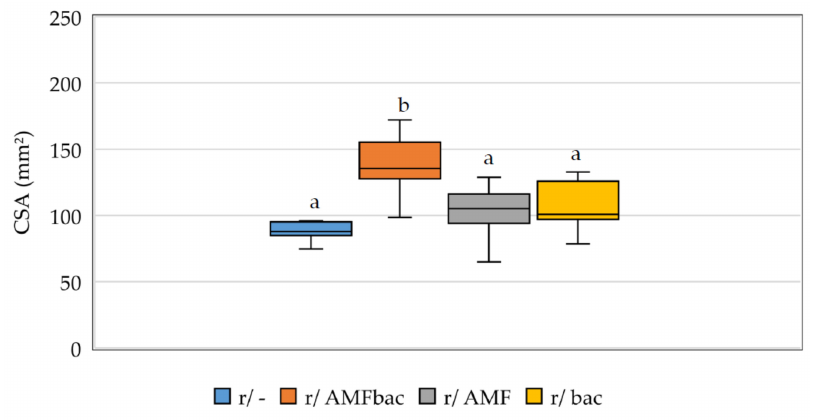
Figure 6. AMFbac Field Test-CSA (mm 2 ), September 2020 (week 18), α =